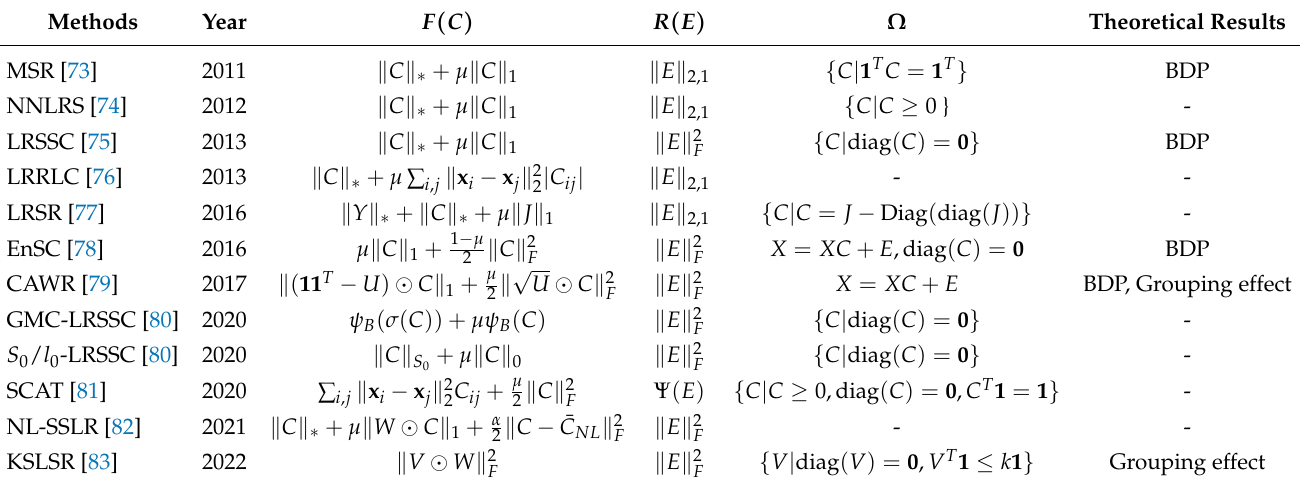
Table 4. The comparison of classical low-rank sparse SC